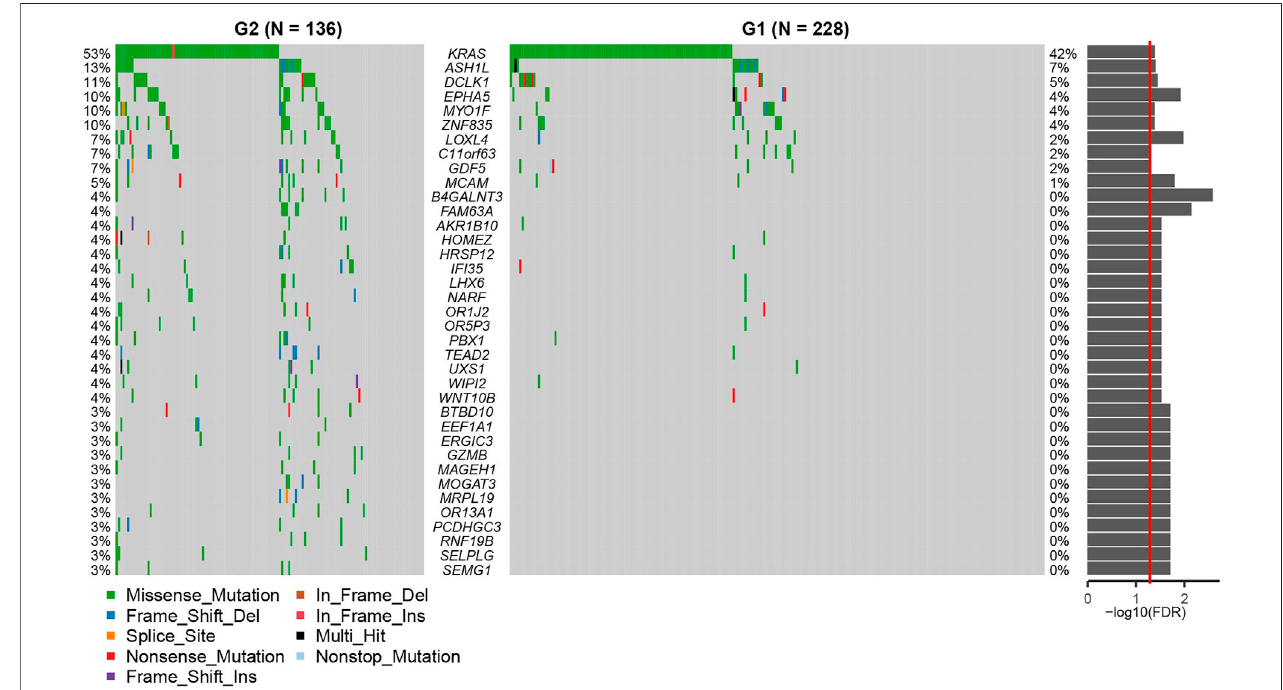
FIGURE 4 | The Oncoprint demonstrating the differences between G2 and G1 subgroups at the genetic level. G2: aggressive (higher-risk survival) subtype; G1: moderate (lower-risk survival) subtype. The p values from the Fisher-exact test are displayed on the right as a bar plot. The red line indicates p (cid:2) 0.05.